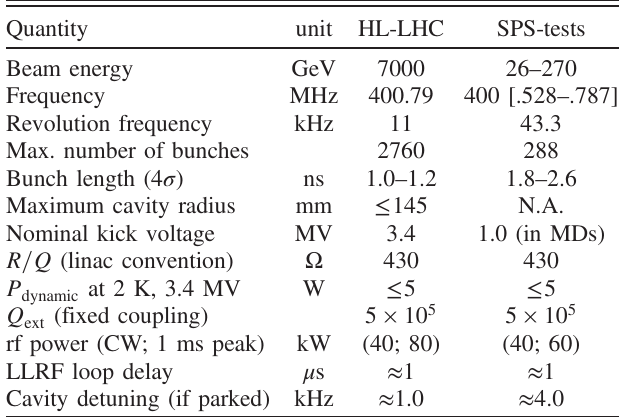
TABLE I. Relevant rf and beam parameters for crab cavities in the HL-LHC and SPS